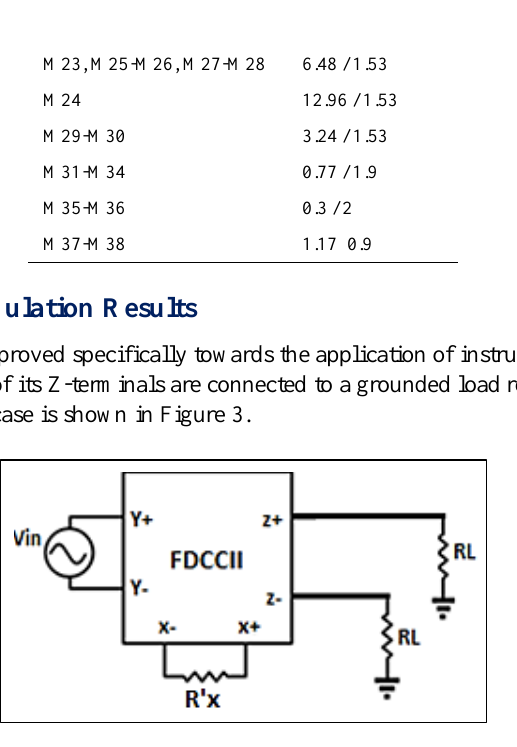
Figure 3. CMIA configuration for voltage inputs.